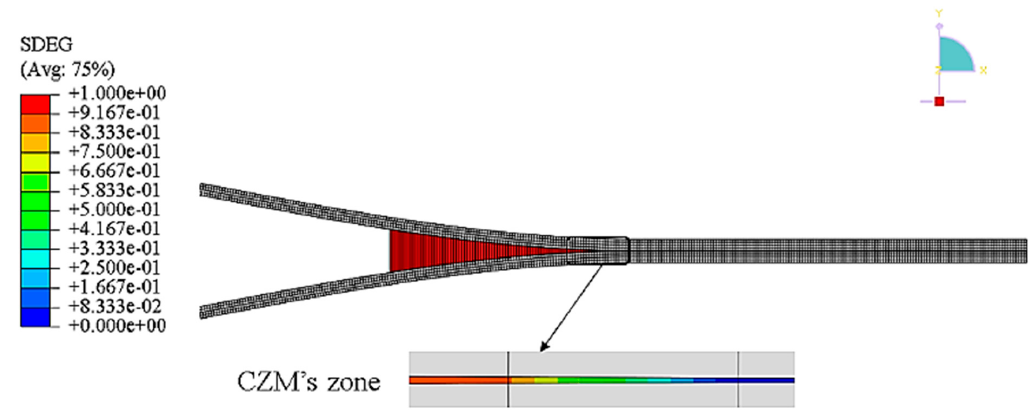
Figure 32. Damage of cohesive elements in the wake of delamination front. Reproduced with permission [246].